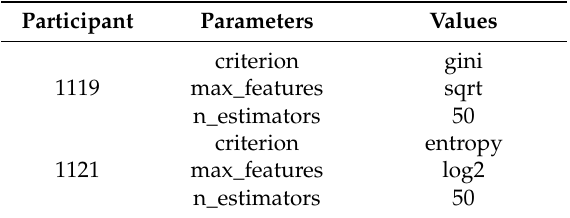
Table 4. Example of different tuned personalized Random Forest models.